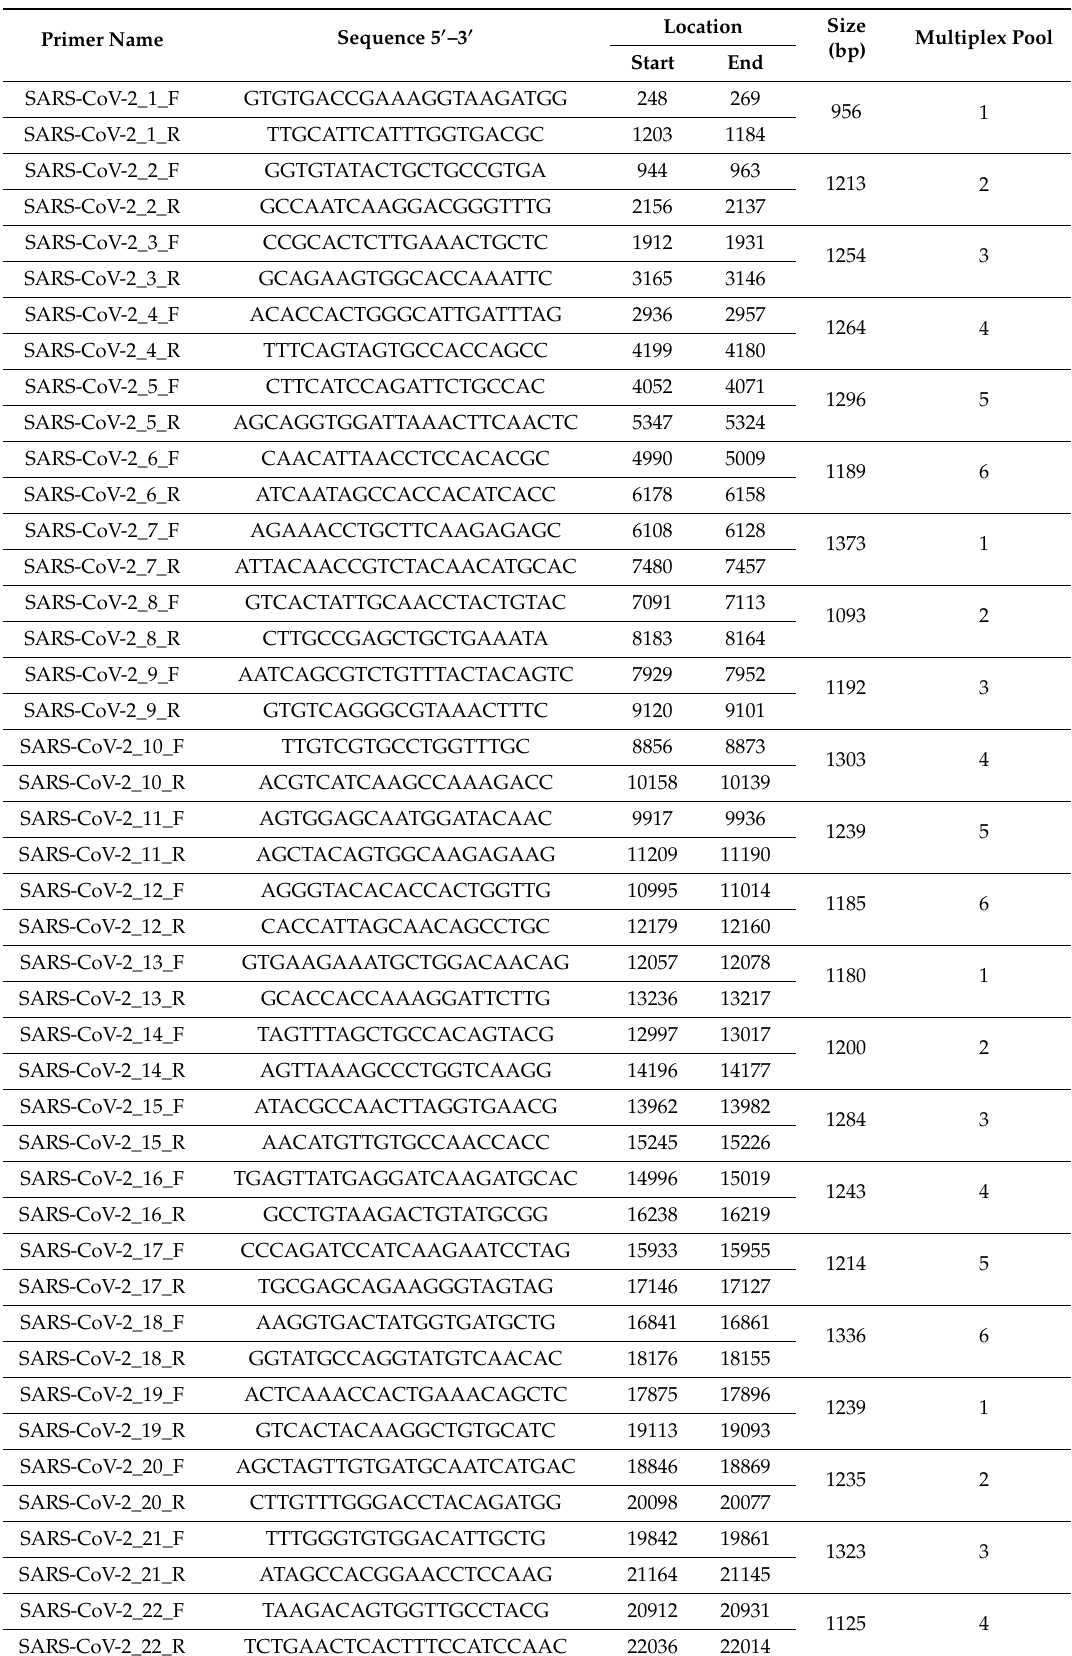
Table 1. Primer pairs by sequence